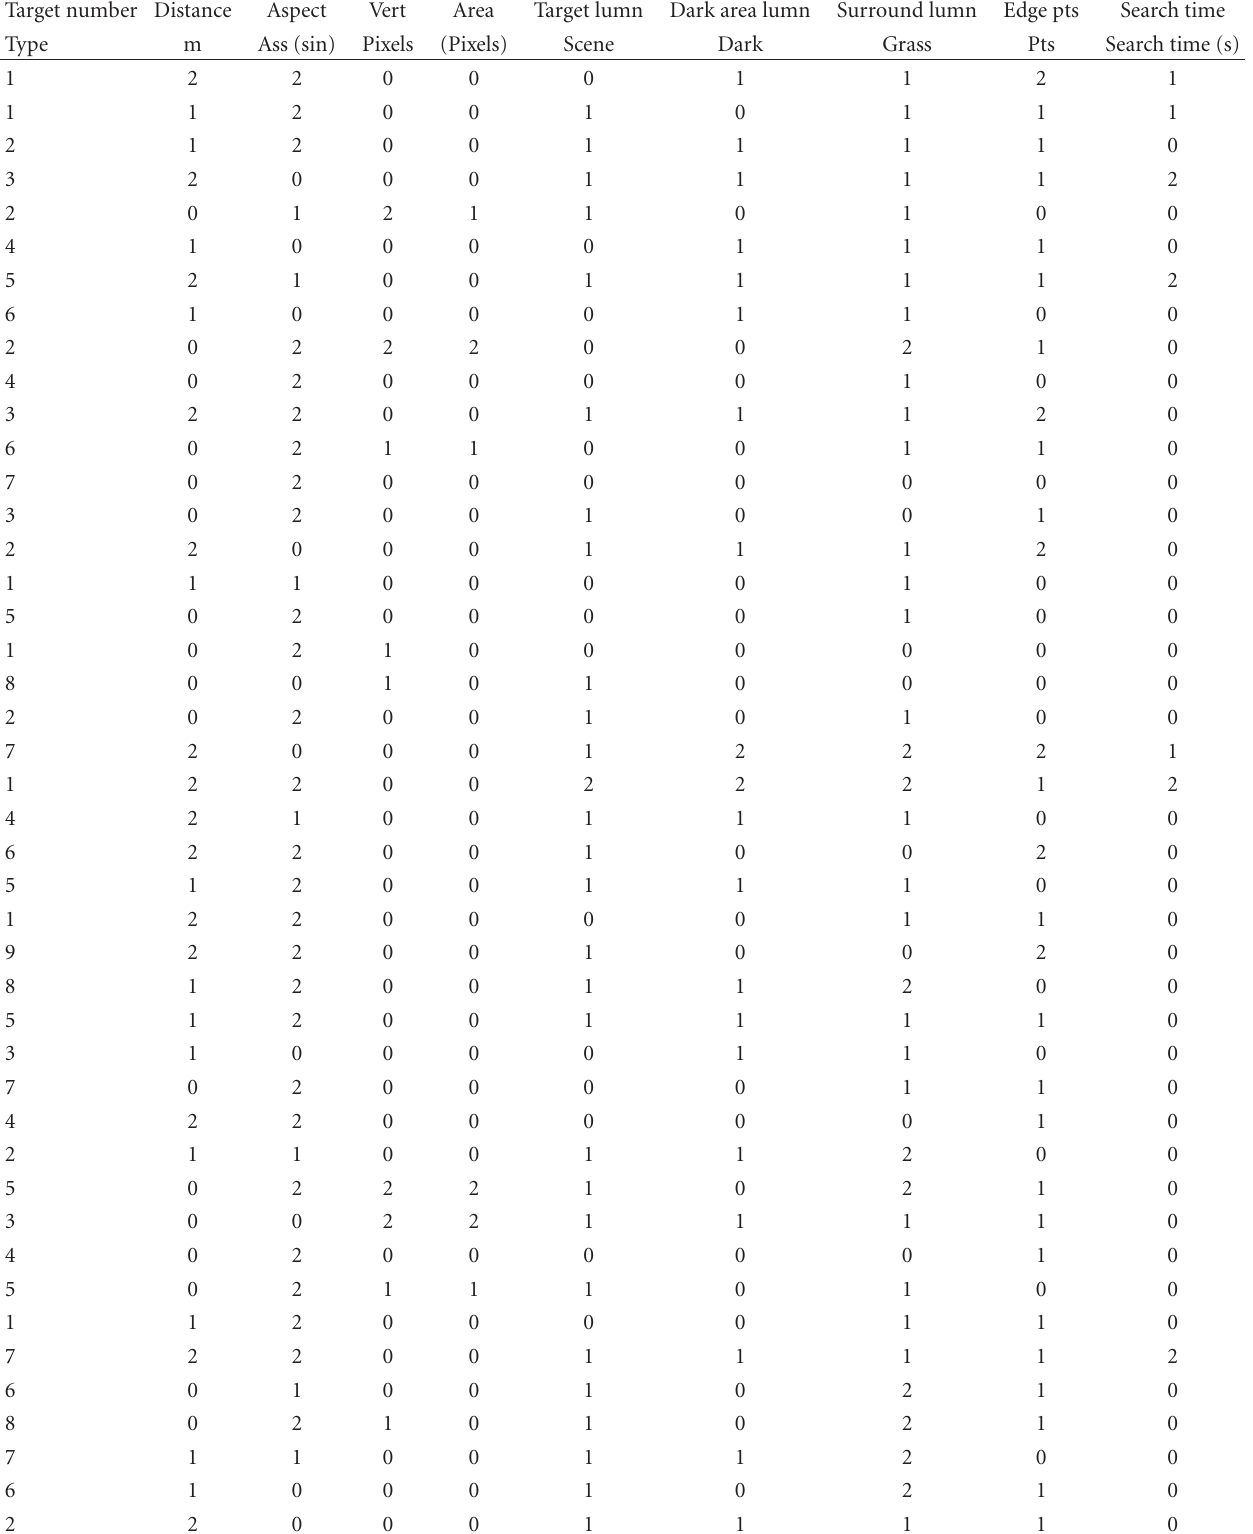
Table 8: Sample data from [5] reduced to trilevel